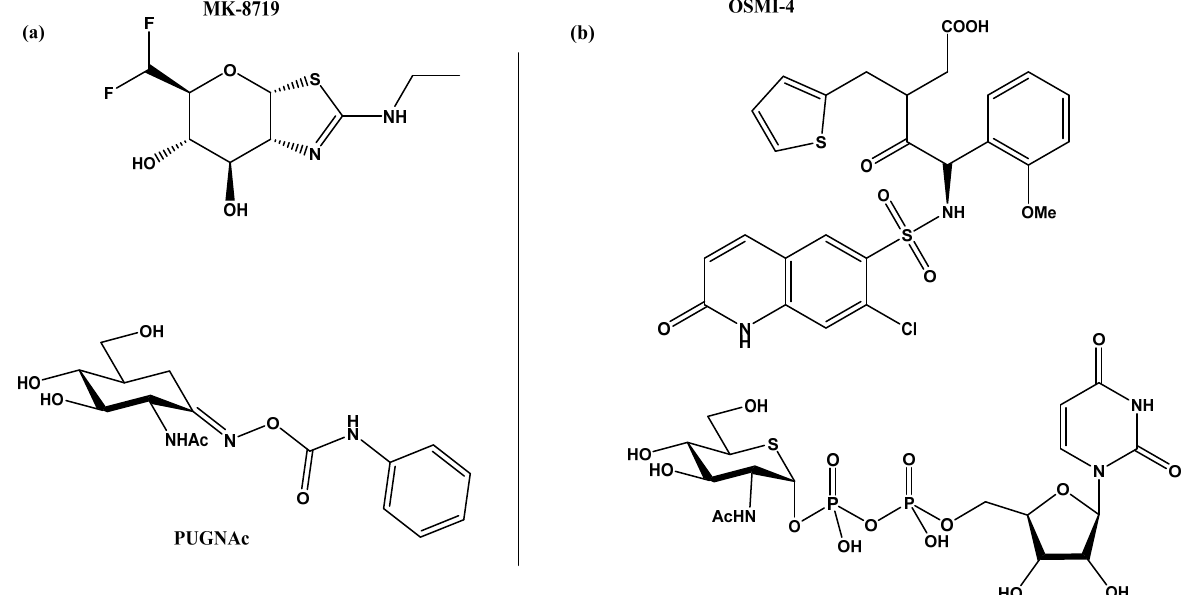
Figure 2. ( a ) MK-871914 and PUGNAc20 OGA inhibitors; MK-8719 potent clinical candidate as OGA inhibitor; ( b ) OSMI-4, the most potent OGT inhibitor to date, and UDP-5S-GlcNAc, an inhibitor biosynthesised by hijacking the hexosamine pathway using a per-acetylated 5S-GlcNAc.